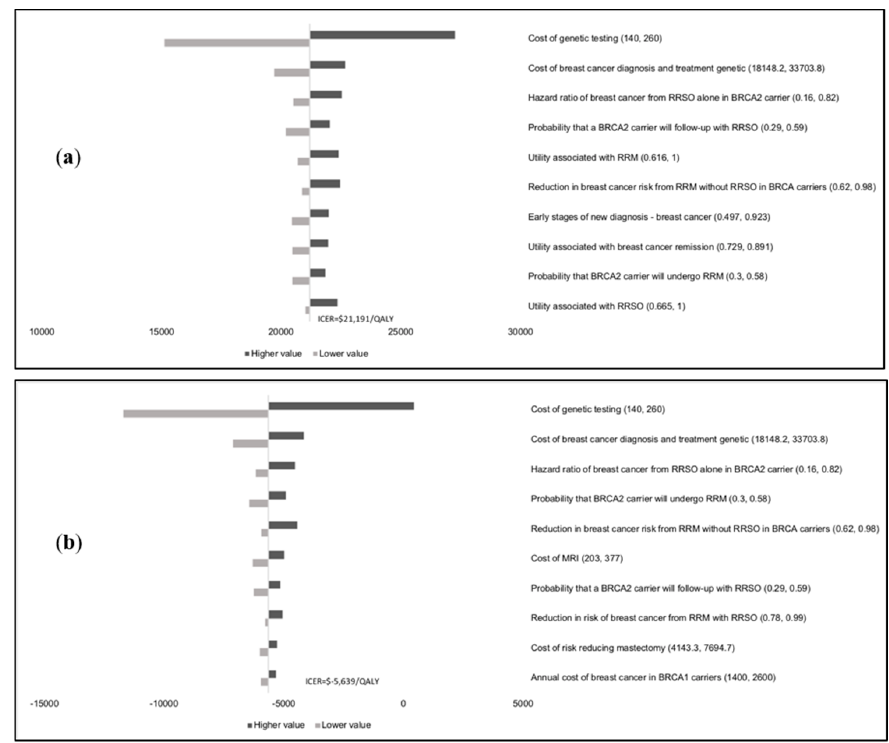
Figure A1. Tornado Diagram in the UK ( a ) from the healthcare payer perspective. ( b ) from the societal perspective.